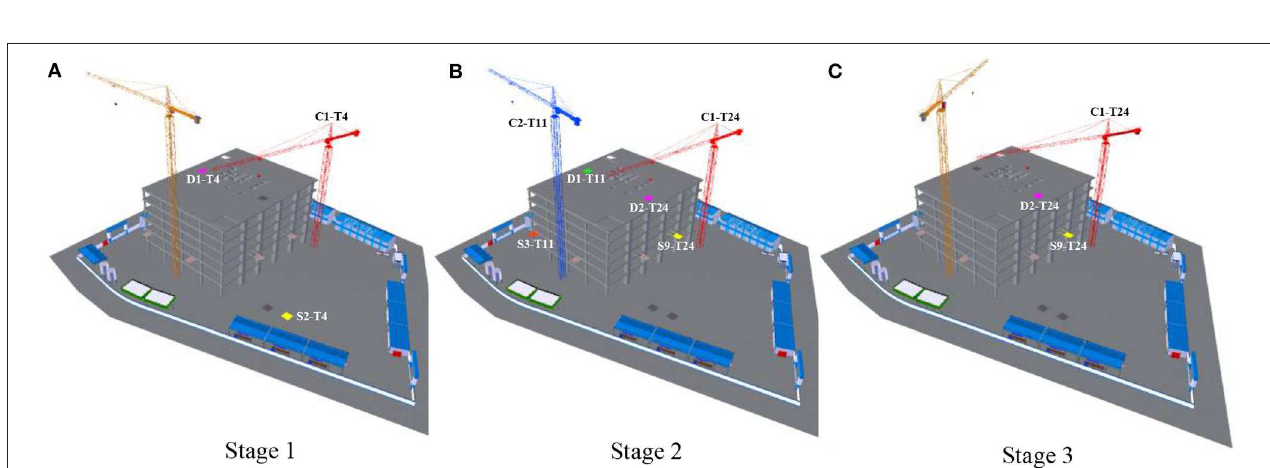
FIGURE 5 | 4-D simulation adopting the normal-level scheme [ (A) , (B) and (C) are Stages 1, 2 and 3, respectively].